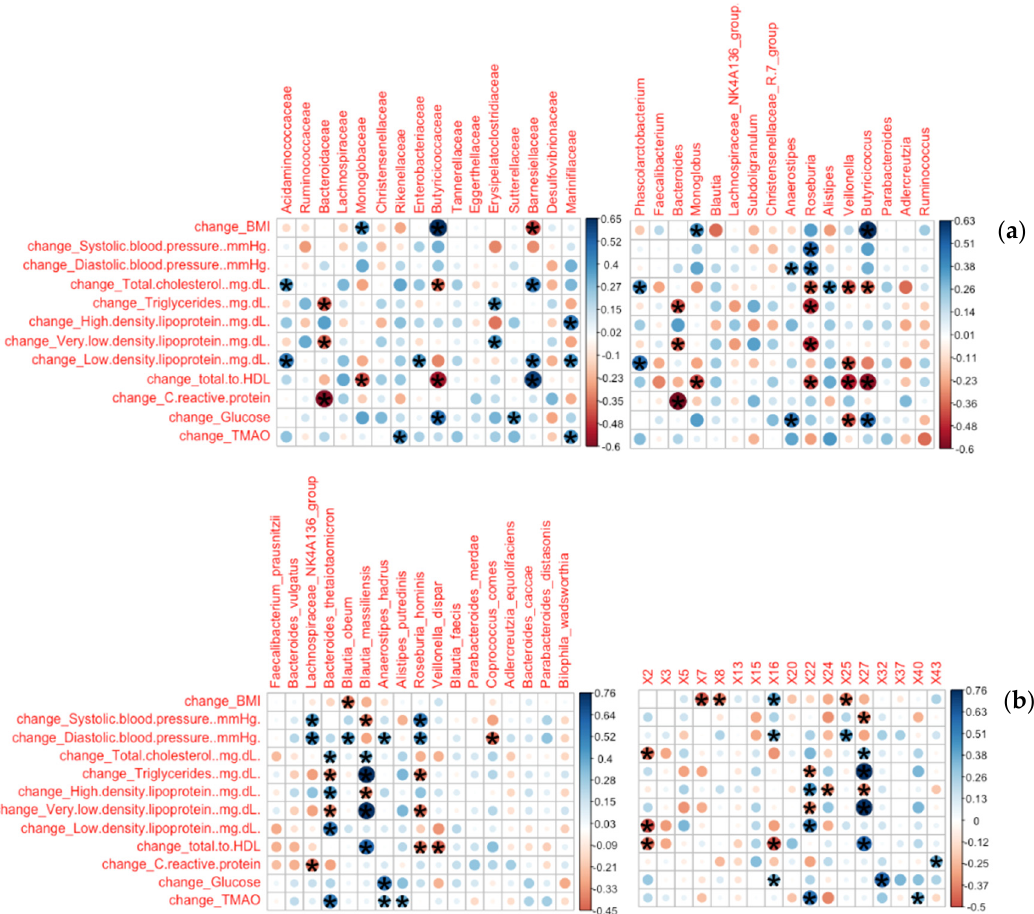
Figure 3. Change in relative abundances correlated with change in anthropometric measures. Spearman correlation of change in relative abundance and change in anthropometric measures across the intervention. Significant correlations are marked with an asterisk, with color and size of the circle indicative of the strength of correlation at right. ( a ) Family and genus level correlations; ( b ) species and ASV level correlations. ASV sequence IDs indicated by X. BMI, body mass index; HDL, high-density lipoprotein; TMAO, trimethylamine N-oxide.